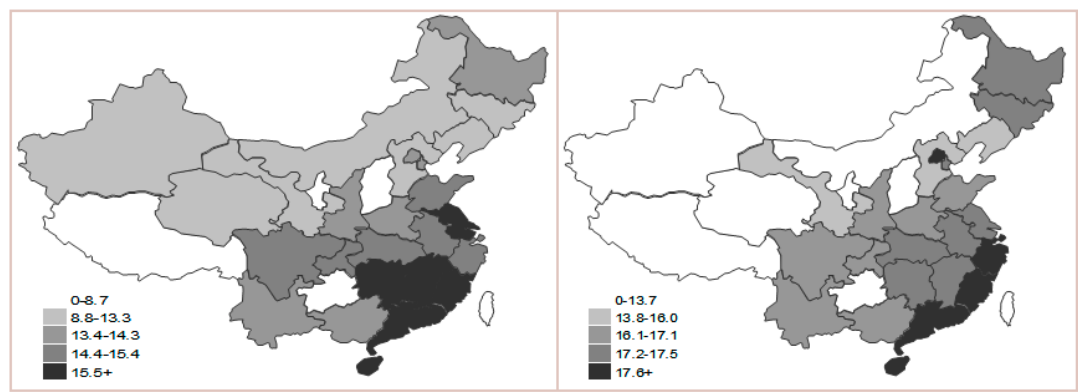
Figure 6. Map of pressure sub-index in 2000 and 2015.